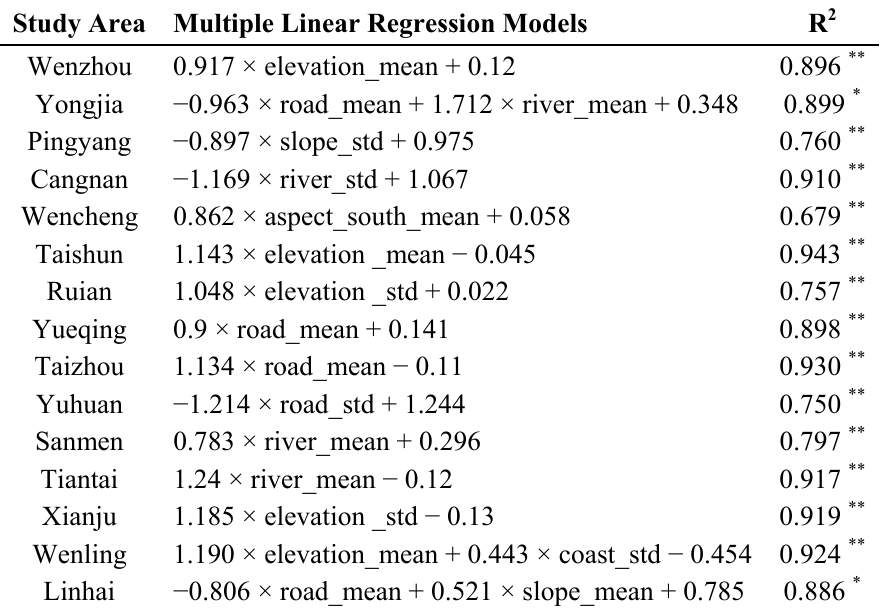
Table 2. Point pattern estimated from multiple linear regression models.